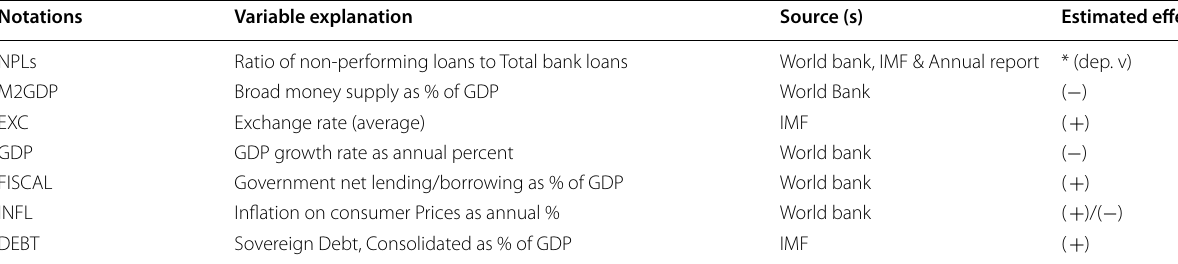
Table 1 The Variables and their anticipated relationships